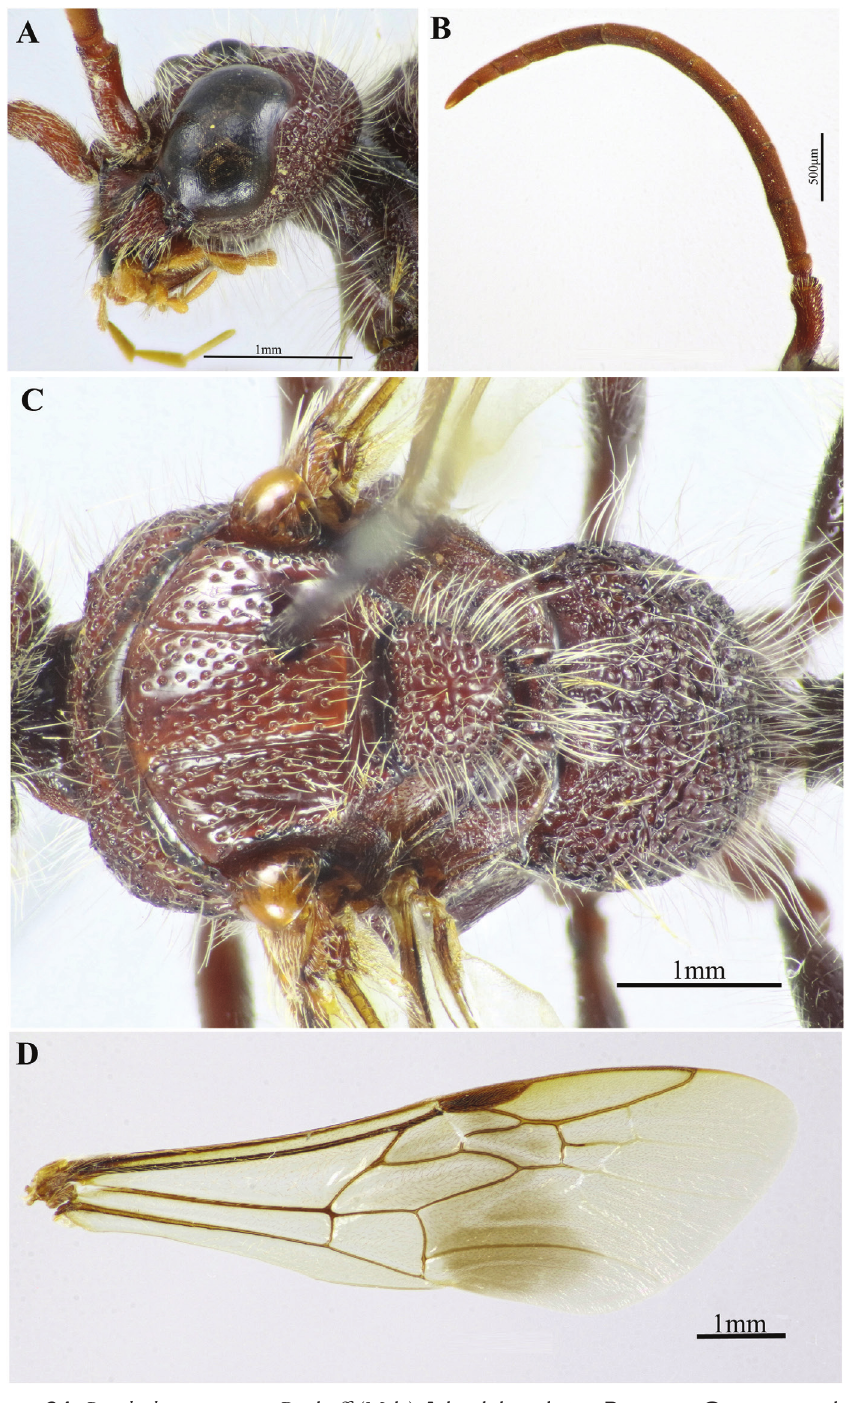
Figure 24. Pseudophotopsis maura Bischoff (Male) A head, lateral view B antenna C mesosoma, dorsal view D right fore